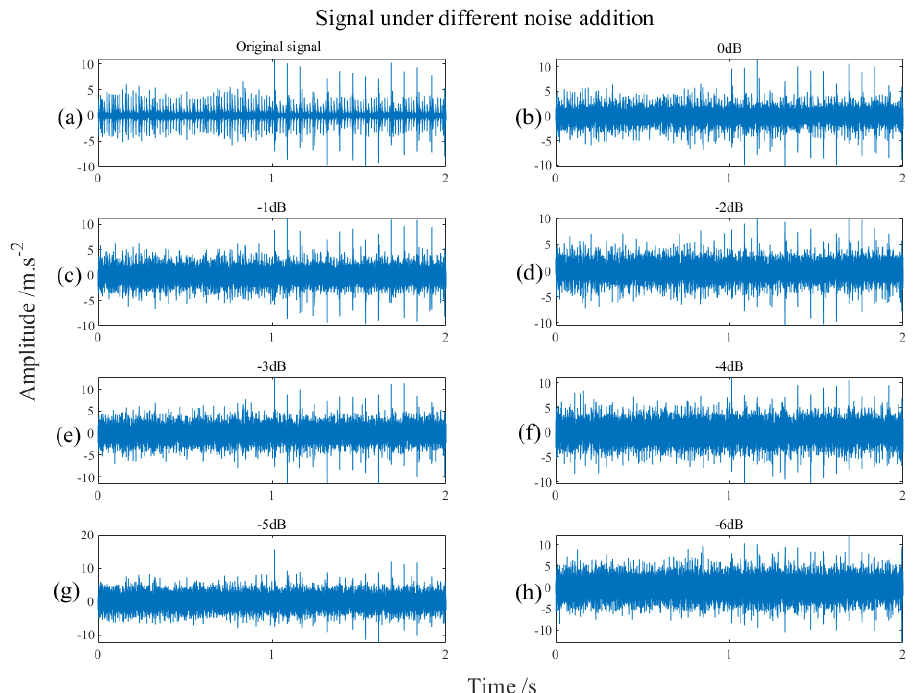
Figure 18. Experimental signals with different levels of noise, ( a ) is the case without adding noise, and ( b – h ) is the case with different levels of noise from 0 dB to − 6 dB respectively.